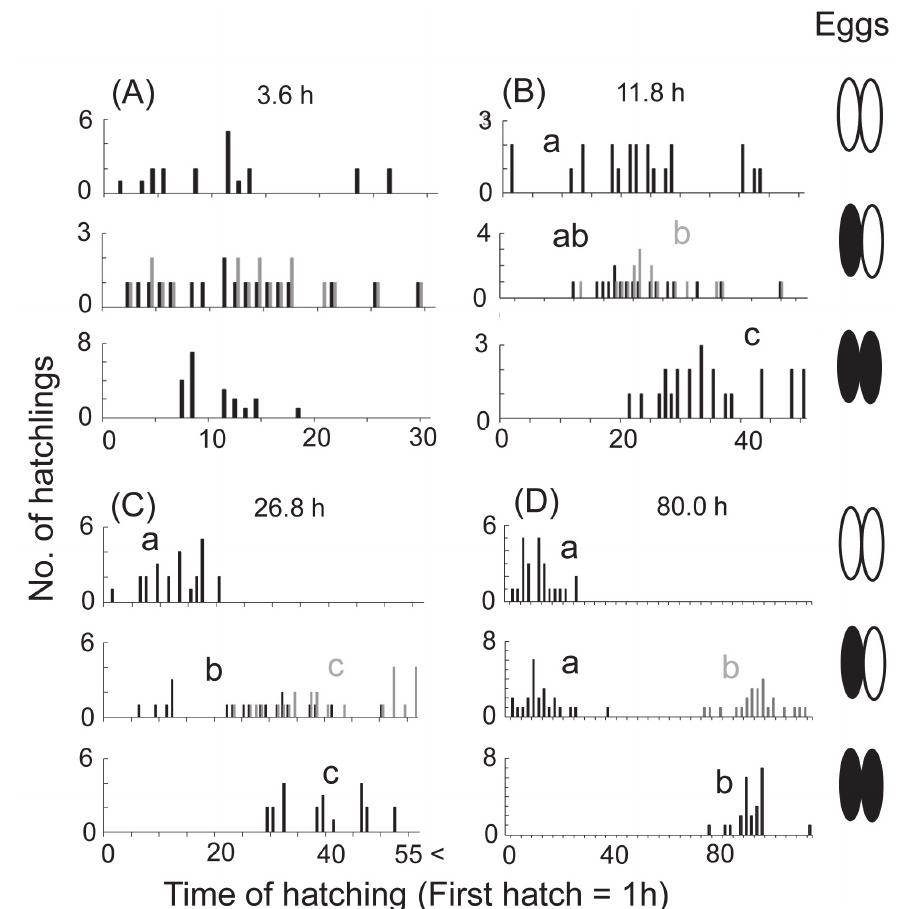
Fig. 11. Hatching patterns of Locusta migratoria eggs derived from different pods and those from the same pods. As indicated above each triplet, the difference in the mean hatching times of the 2 pods (top and bottom panels) ranged from 3.6 to 80 h ( A–D ). In the mixed pairs (middle panel), the first and second hatchings are shown in black and light-colored bars. Different lower-case letters indicate significant differences in mean values at the 5% level with Tukey’s multiple test. The diagrams on the right of the figure show combina- tions of eggs from two pods expressed as white and black eggs,